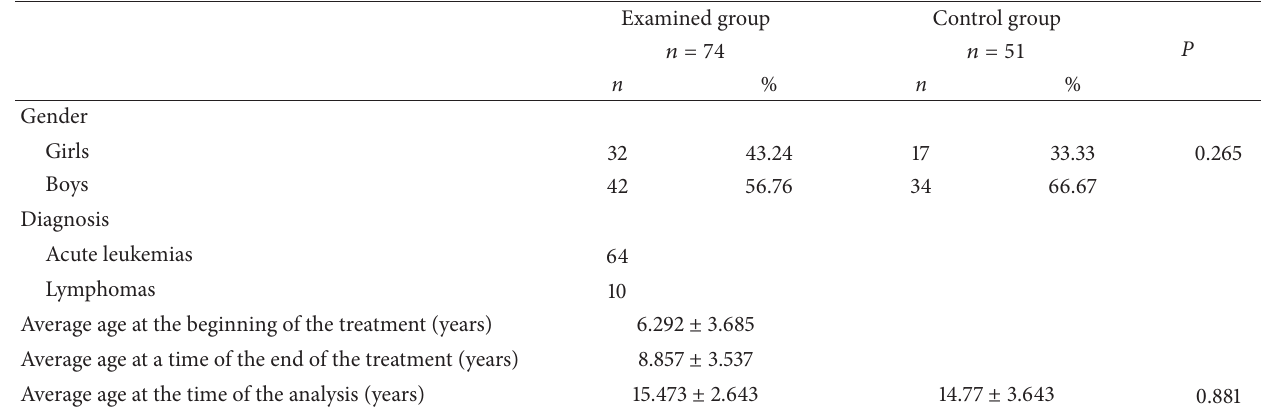
Table 1: Characteristics of the examined and control